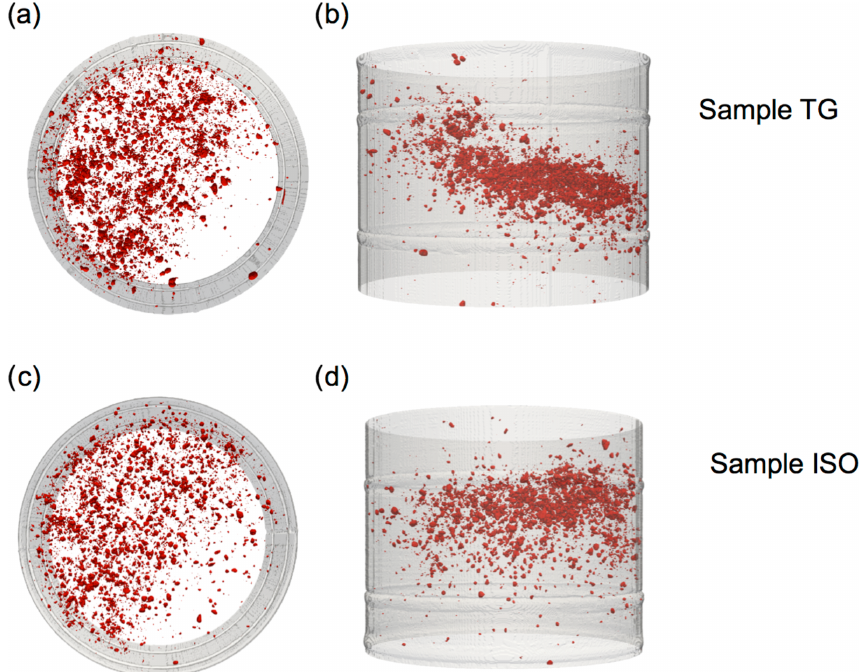
Figure A1. A 3-D view of the initial dust location (red) in the temperature gradient experiment (a, b) and the isothermal experiment (c, d) from top view (a, c) or side view (b, d) . The aluminum sample holder inner contour is shown in transparent gray. The scale is indicated by the sample holder inner diameter, which is